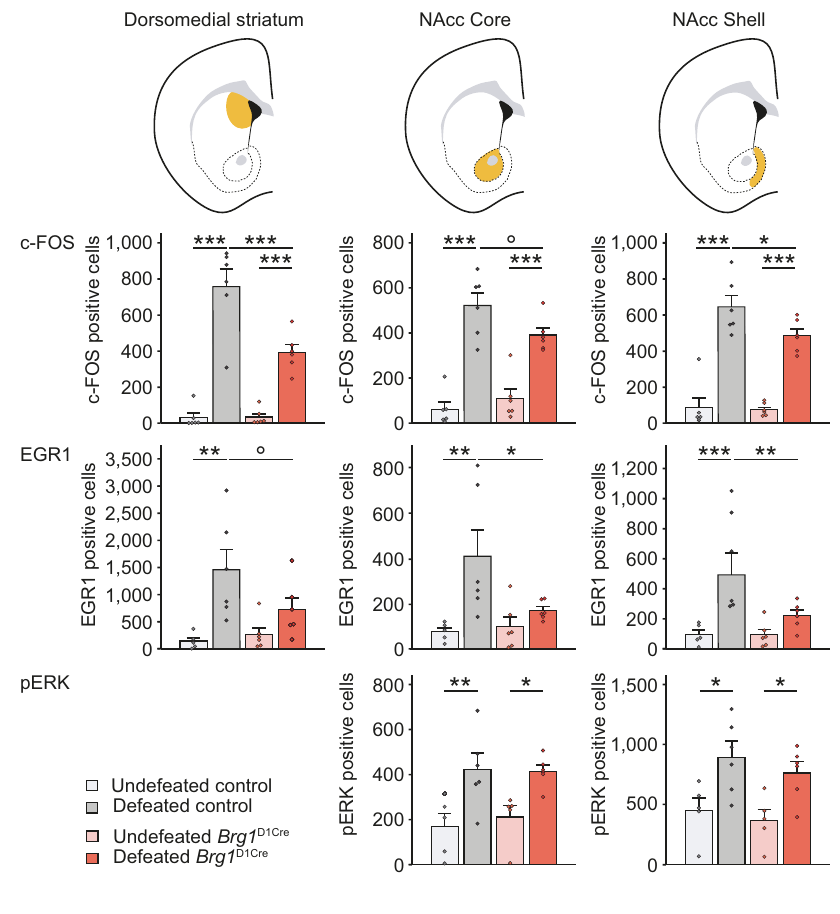
Fig. 5 Immediate early genes induction of expression and ERK pathway activation in response to a single social defeat in control and Brg1 D1Cre mice. First row, c-fos gene induction by an acute social defeat in control and Brg1 D1Cre mice in the dorsomedial striatum (left chart), NAc core (middle chart) and NAc shell (right chart). Locations of the corresponding structures are indicated in orange on the schemes above. Undefeated control n = 6, defeated control n = 6, undefeated Brg1 D1Cre n = 6, defeated Brg1 D1Cre n = 6. Two-way ANOVA. Dorsal striatum: main stress effect F(1,20) = 96.66; p <